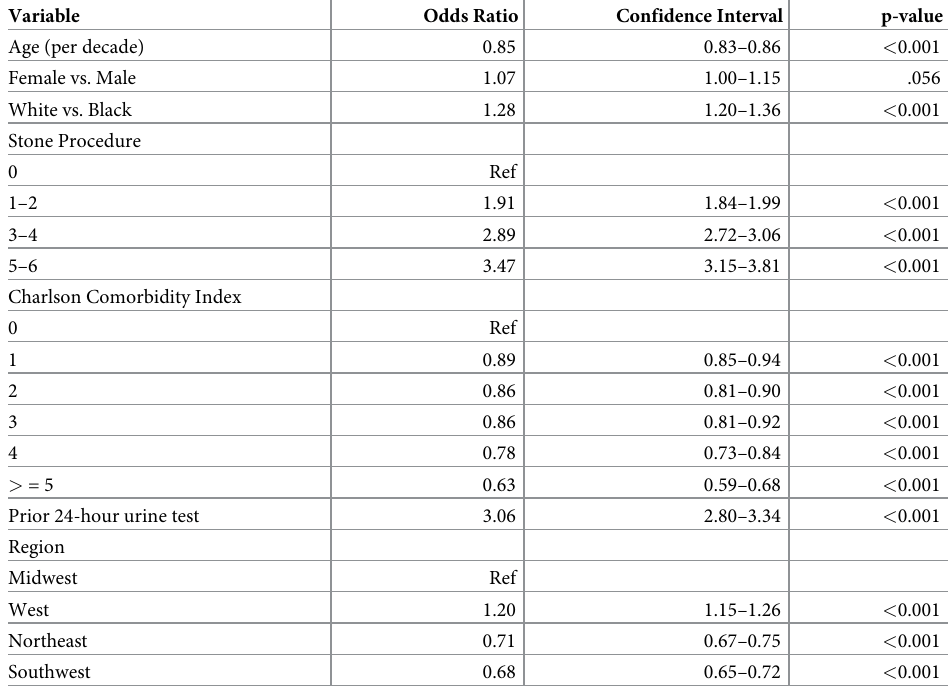
Table 4. Multivariable logistic regression reporting the odds of completing a 24-hour urine collection.